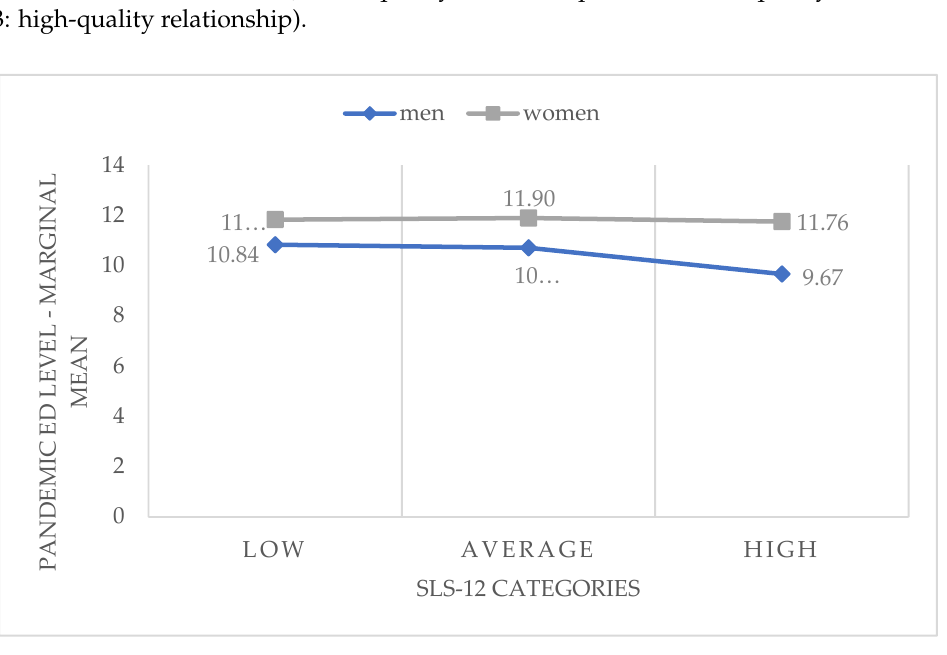
Figure 3. Interaction between gender and the assessment of relationship quality (SLS-12 categories) as predictors of perceived pandemic-related difficulties in women and men (N = 1405) (marginal means from GLM model).